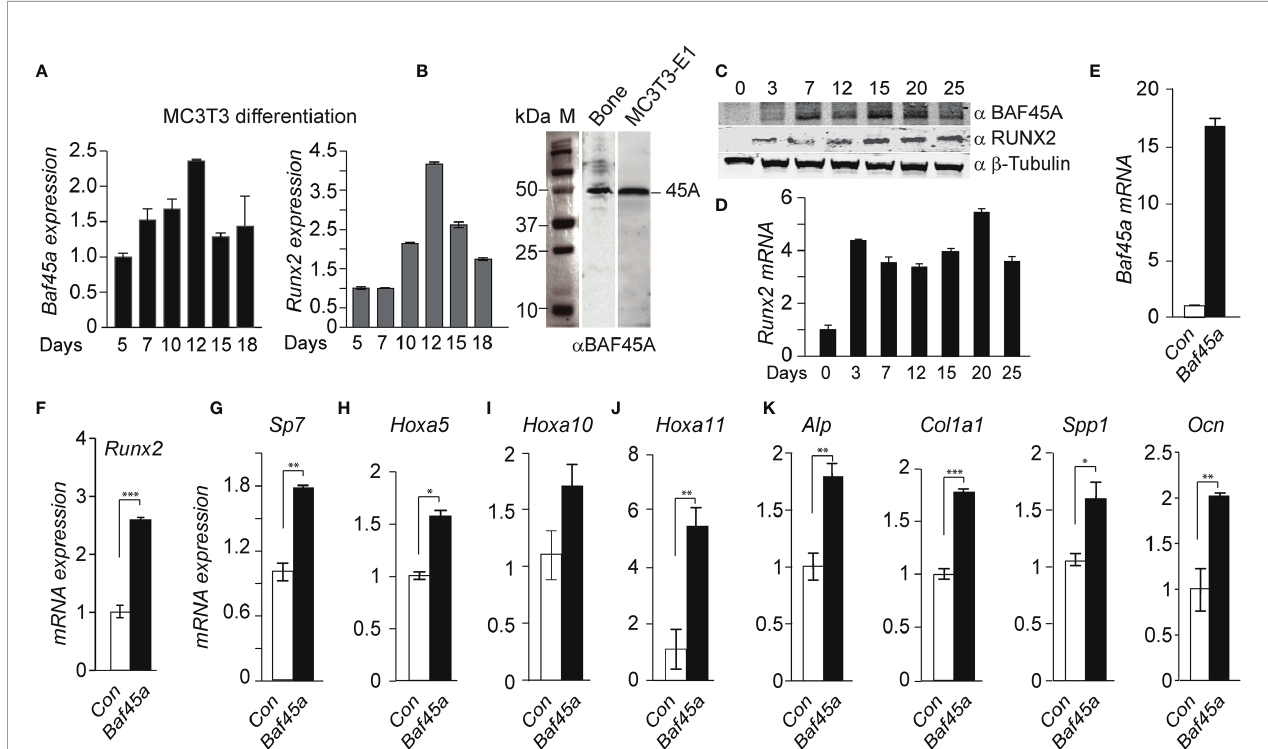
FIGURE 2 | Baf45a expression levels induce gene expression pro fi les for osteoblast differentiation. (A) Relative expression levels of Baf45a (left panel) and Runx2 (right panel) were obtained by real-time RT-qPCR using DNase I treated total RNA isolated from murine preosteoblast MC3T3-E1 cells induced to differentiate for 18 days. Gapdh mRNA pro fi le was used as an experimental control. (B) Representative Western blot analysis with anti-BAF45A antibody of lysates from the femur and MC3T3-E1 cells. Molecular weight markers were indicated in kDa. (C) Relative protein levels of BAF45A (upper panel) and RUNX2 (middle panel) were obtained by Western blot analysis using total cell lysate isolated from murine calvarial osteoblast cells induced to differentiate for 25 days. Beta Tubulin protein pro fi le (lower panel) was used as loading control. (D) Relative expression levels of Runx2 were obtained by real-time RT-qPCR using DNase I treated total RNA isolated from murine calvarial cells induced to differentiate for 25 days. (E) Overexpression of Baf45a in MC3T3-E1 osteoblast cells normalized to Gapdh after 72 hours by RT-qPCR. (F – J) Expressions of Runx2 , Sp7 (osterix) osterix, Hoxa5 , Hoxa10 , and Hoxa11 were assessed by RT-qPCR and normalized to Gapdh . (J) Early markers Alp and Col1A1 and (K) late markers Spp1 ( Opn ), and Ocn were assayed. Statistical signi fi cance was determined by Student ’ s t-test (*P ≤ 0.05; **P ≤ 0.01; ***P ≤ 0.001 versus matched control). Gapdh expression was used as the